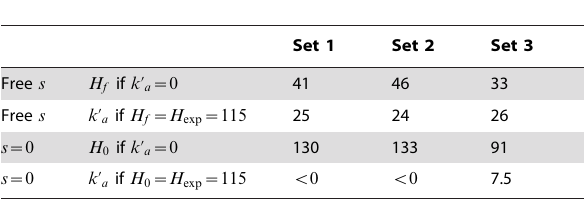
Table 1. Spring constant H and constant k ’ a of monoolein.